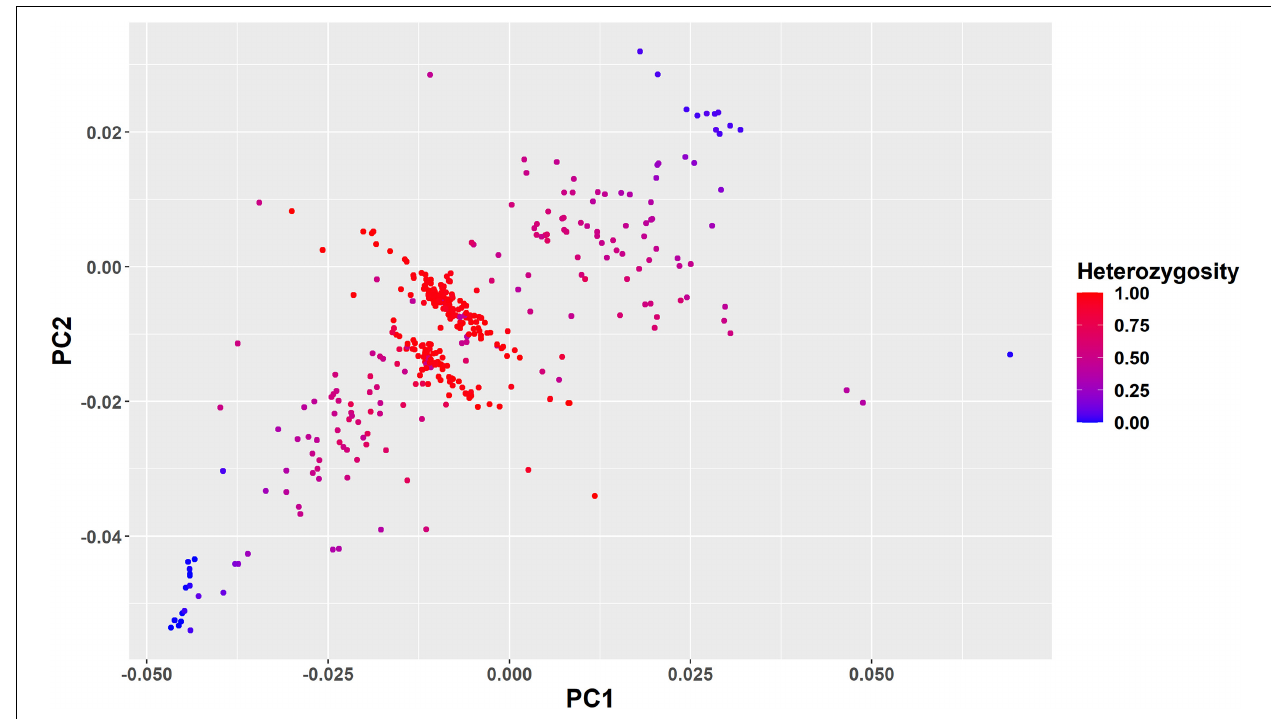
FIGURE 6 | Plots of PC1 vs. PC2 for all West African crossbred animals showing their ancestral origin heterozygosity as color code from red (heterozygosity = 1) to blue (heterozygosity = 0).